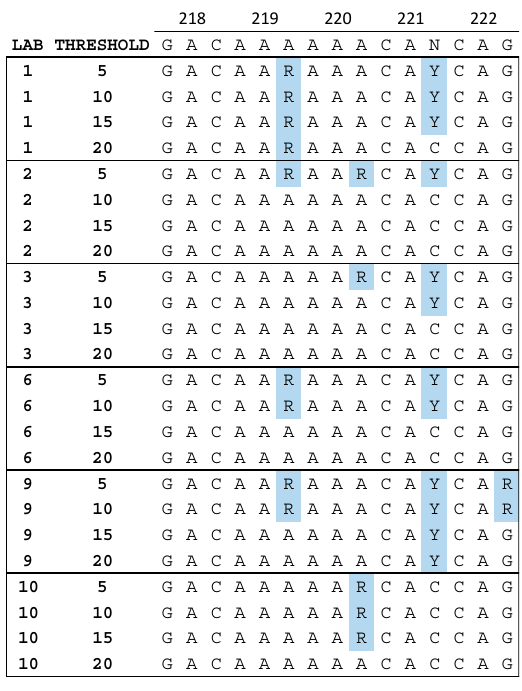
Figure 2. Nucleotide sequence alignment for six laboratories. The VQA Sanger sequencing (SS) consensus is shown at the top. Mixtures of A and G (R) or C and T (Y) that were reported by some but not all laboratories are highlighted in blue. The sequences from laboratories 5, 7, and 8 did not contain any mixtures in this region, and those from laboratory 4 contained the Y in codon 221 at all thresholds reported (5%, 10%, and 15%).